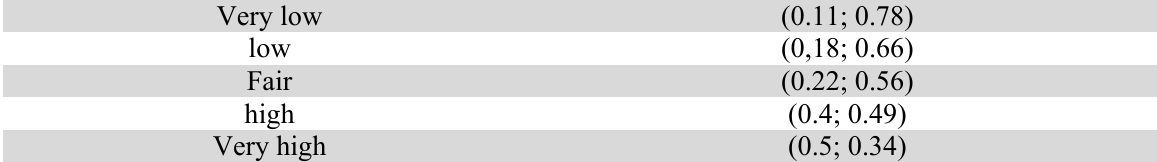
Definitions of linguistic variables for the importance of each criterion